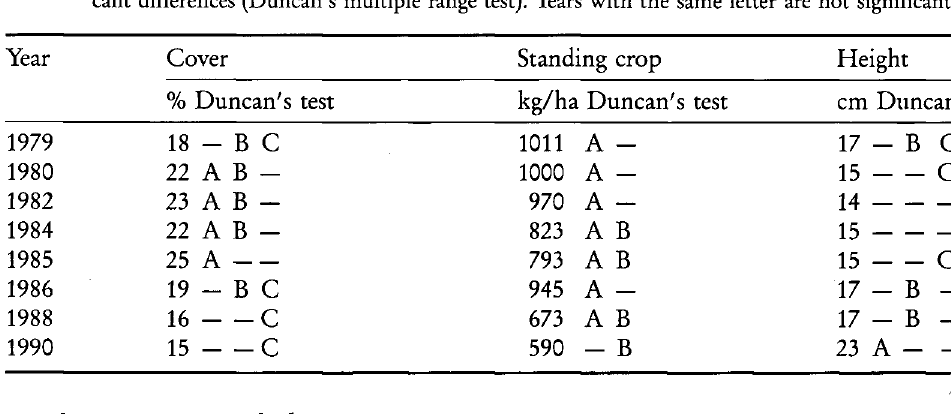
Table 1. Mean cover, mean standing crop and mean height of Calluna vulgaris in the control plots and test of signifi cant differences (Duncan's multiple range test). Years with the same letter are not significantly different.